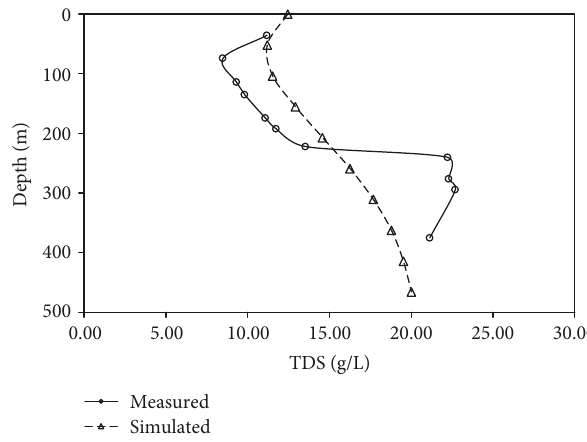
Figure 6: Comparison of the simulated TDS with the measured TDS in well